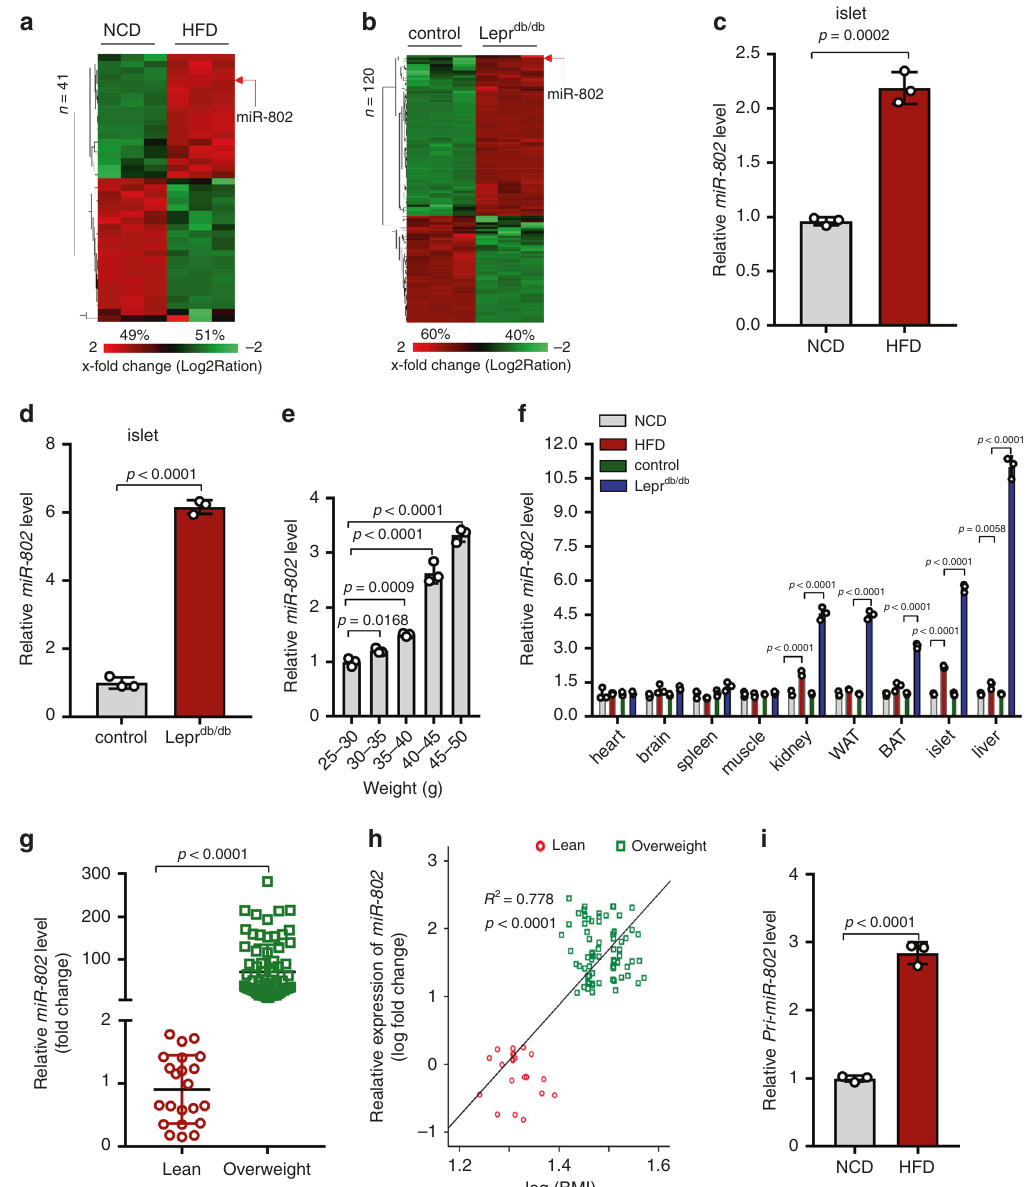
Fig. 1 miR-802 expression level in obese mice and obese individuals. Heat map diagram illustrating the differential expression of miRNAs in islets of HFD compared to normal chow-diet (NCD) mice ( a ), n = 8 NCD group and n = 7 HFD group), and in Lepr db/db compared to wide type control mice ( b ) ( n = 8 control group and n = 7 Lepr db/db group). Red and green indicate increased and decreased gene expression levels, respectively. miR-802 was signi fi cantly upregulated in islets of HFD mice ( c ), and Lepr db/db mice ( d ) ( n = 7) compared to NCD and wild type control as measured by qRT-PCT. e qRT-PCR was performed to measure the expression level of miR-802 in the islets at different stages (after 0-week, 4-week, 6-week, 8-week and 16-week feeding HFD) during the development of obesity inducing diabetes ( n = 5). f qRT-PCR was performed to evaluate the expression levels of miR-802 in different tissues of obese and wild type mice ( n = 7). g The expression levels of miR-802 in the serum extracted from lean individuals ( n = 22) and overweight individuals ( n = 72), using Ce - miR - 39 - 1 as positive control. miR-802 expression was set to 1 in SD. Data sets were statistically analyzed using two-tailed unpaired Student ’ s t test and Bonferroni Post-hoc correction. h Correlation between miR - 802 levels and BMI. Pearson ’ s correlation coef fi cients ( r ) and p values are shown. i The expression level of Pri-miR-802 in the islets of HFD and NCD mice were analyzed by qRT-PCR ( n = 3). All experiments above were performed in triplicates, and each group contained three batches of individual samples. The p -values by Pearson ’ s correlation test h, two-tailed unpaired Student ’ s t test c, d, g, and i, one-way ANOVA e, or two-way ANOVA f are indicated. Data represent the mean ± SD. Source data are provided as a Source Data fi